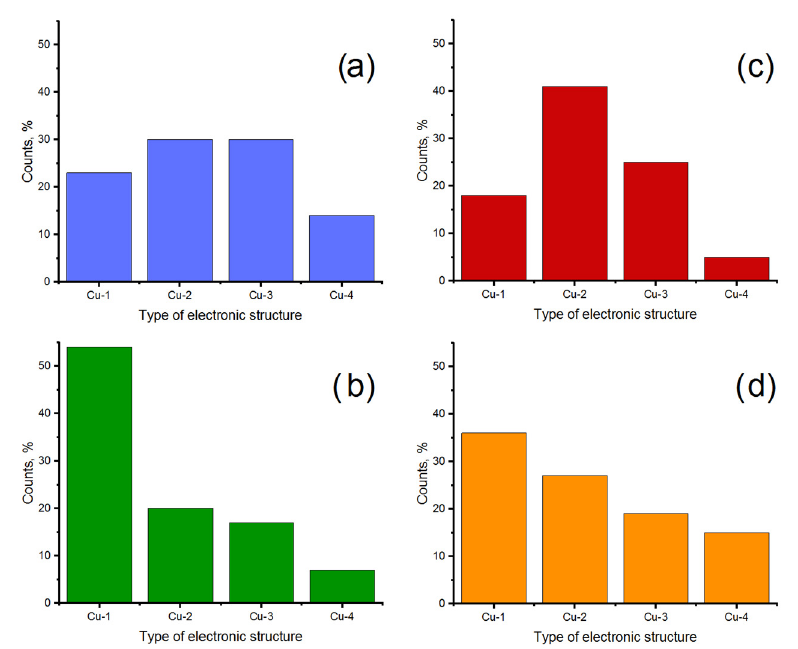
Figure 3. Ratio between various types of local electronic structure on the surface of nanoparticles: ( a ) after calcination and precursor decomposition; ( b ) after exposure to CO (400 L, T = 300 K, Δ V = − 1 V); ( c ) after oxidation in air ( t = 40 h, T = 300 K); ( d ) after exposure to CO (400 L, T = 300 K, Δ V = +1 V). To obtain each histogram, at least 50 counts were performed.